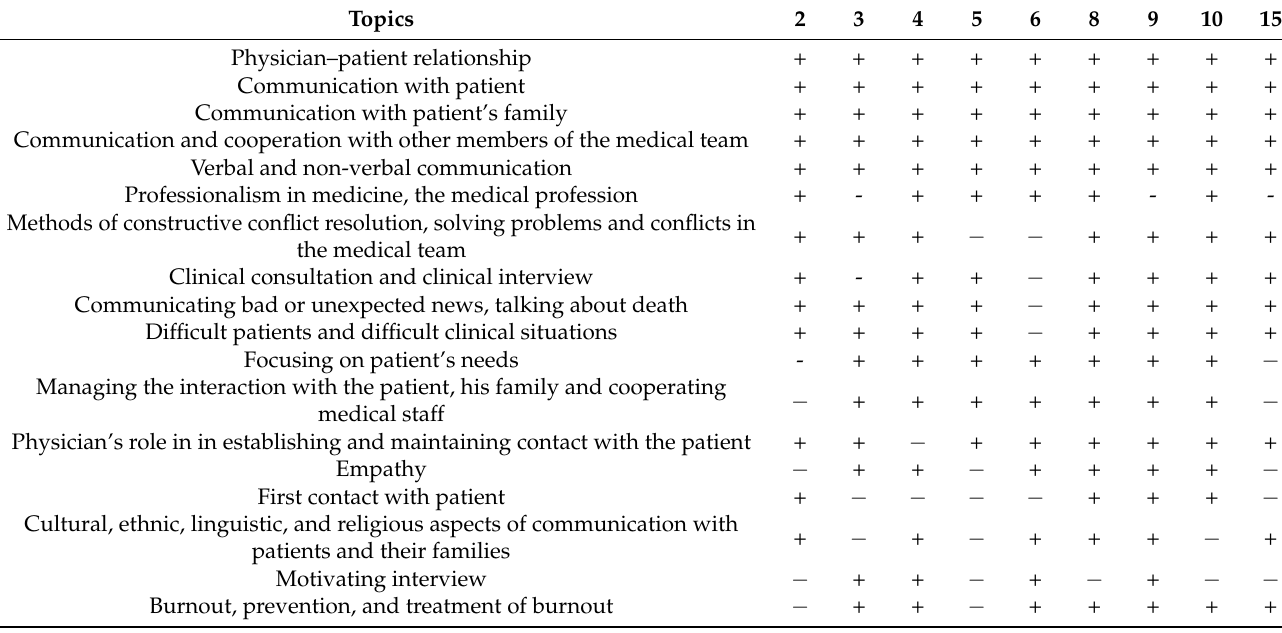
Table 2. Analysis of the content of the compulsory courses offered. The information was extracted from nine universities that posted their syllabi online for public use. The universities are coded with numbers, and the coding is the same as in Table 1 and Figures 3 and